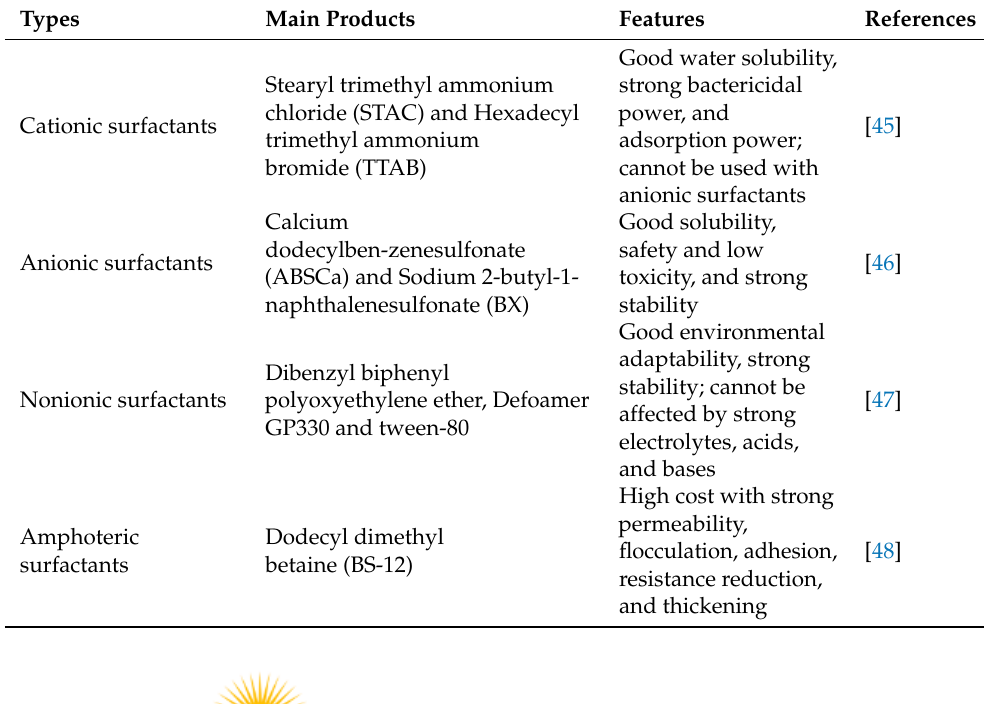
Table 2. Main surfactants used for the production of microbial pesticides.